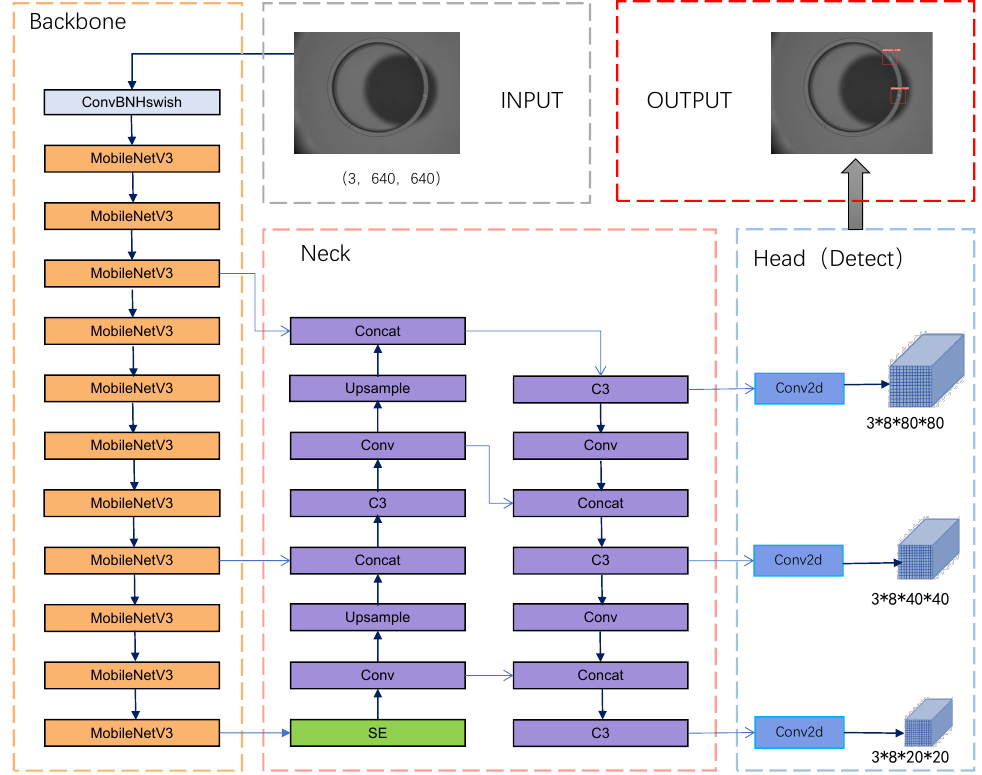
Figure 4. The improved YOLOv5s network